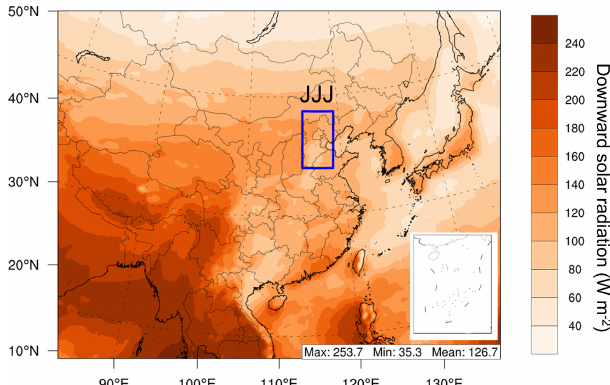
Figure 1. Simulation domain and locations of the Jing-Jin-Ji region in China. The color shows simulated daily average downward short- wave solar radiation (SWDOWN) at the bottom in January